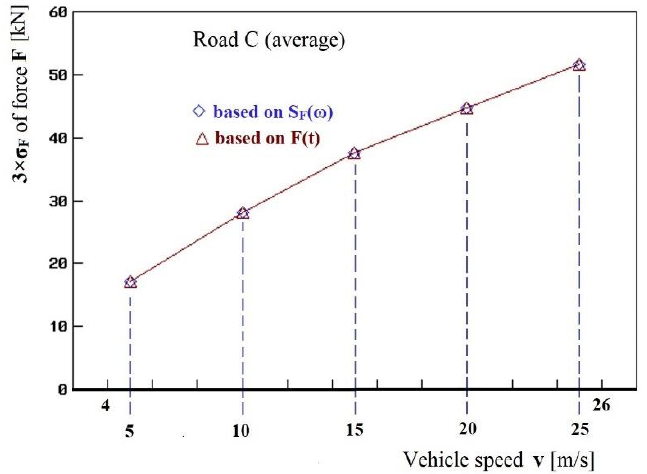
Figure 14. Values of 3 × σ F of the dynamic component of the vertical force on the connection between the tractor ’ s fifth wheel and the kingpin of the semitrailer, for road C (average) and the five vehicle speed values v considered, i.e., 5 m/s, 10 m/s, 15 m/s, 20 m/s, and 25 m/s. Comparison of the results obtained from the frequency analysis and those calculated on the grounds of the generated realization of F(t).